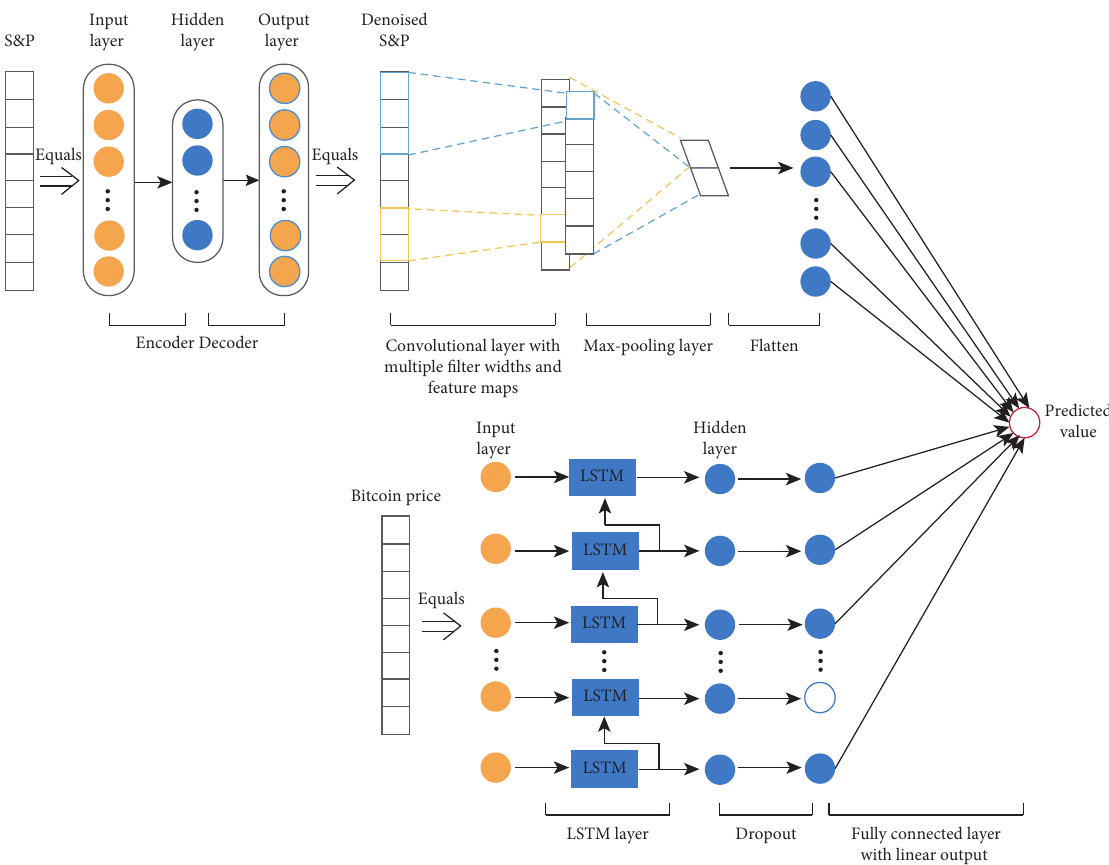
Figure 1: The architecture of the proposed